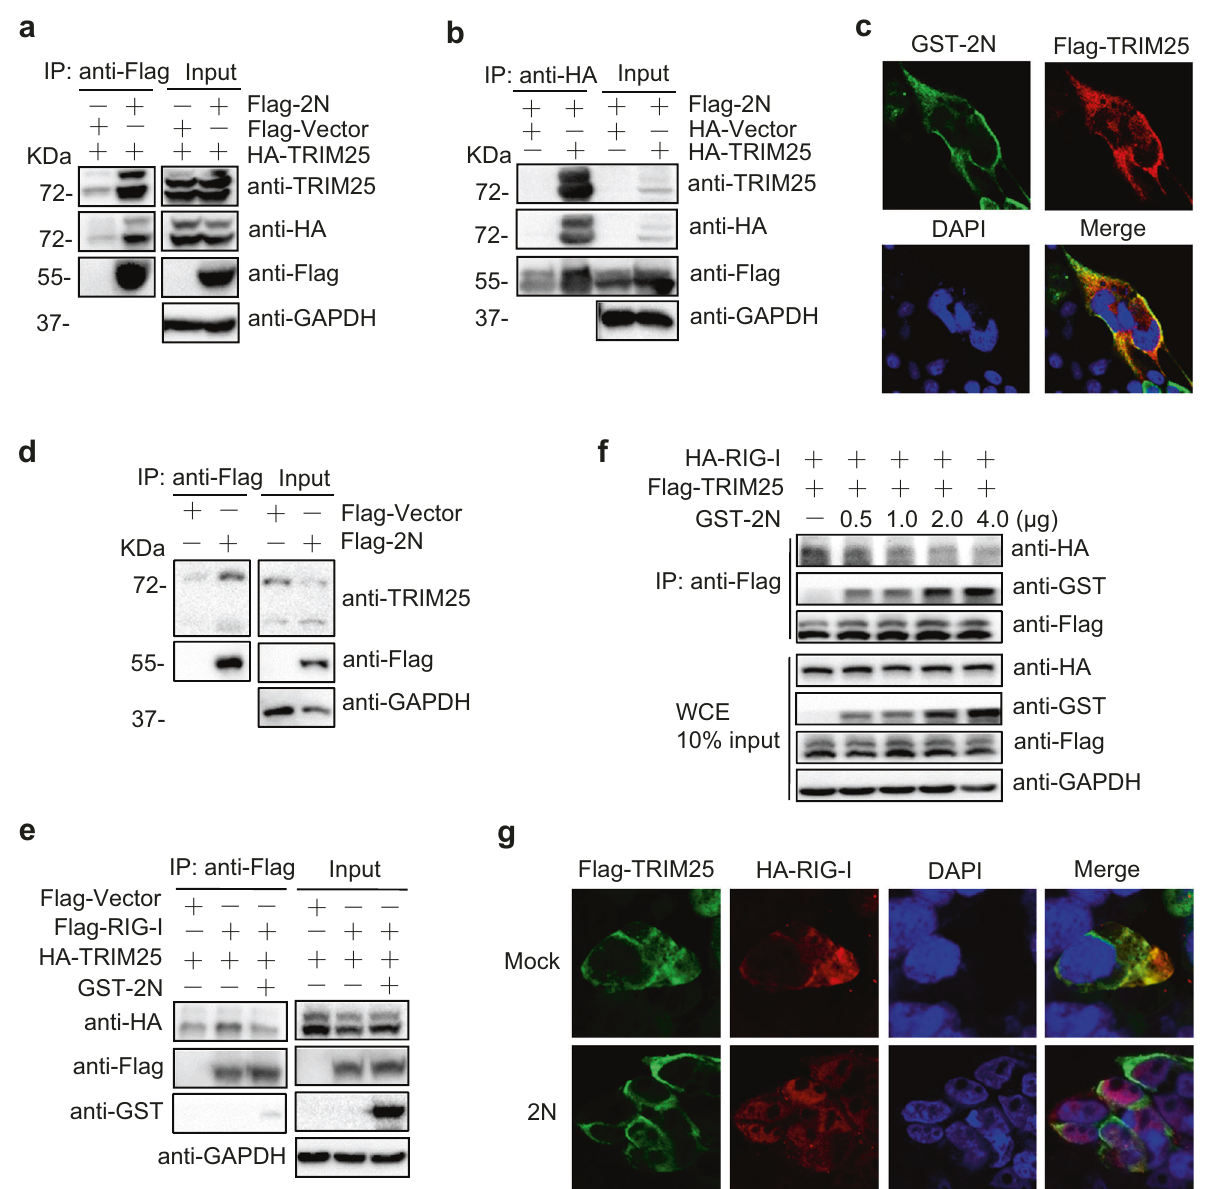
Fig. 5 2N protein inhibits the interaction of TRIM25 and RIG-I through competitively binding to TRIM25. a HEK293T cells were transfected with the plasmids expressing 1 μ g Flag-tagged SARS-CoV-2 N (Flag-2N) or empty-vector together with HA-TRIM25 in six-well plate. After 24 hpt, the cell lysates were subjected to anti-Flag immunoprecipitation (IP) and analyzed by immunoblot with anti-TRIM25, HA, and Flag antibodies, GAPDH was used as a loading control. b HEK293T cells were transfected with the indicated plasmids as in a for 24 h, the cell lysates were subjected to anti-HA IP and analyzed by immunoblot. c HEK293T cells were transfected with the plasmids expressing 0.25 μ g GST-2N and Flag-TRIM25 in 24-well plate. After 24 hpt, the cells were subjected to immuno fl uorescence with anti-GST and Flag antibodies. d HEK293T cells were transfected with Flag-2N or empty vector for 24 h, the cell lysates were subjected to anti-Flag IP and analyzed by immunoblot with anti-TRIM25 and Flag antibodies. e HEK293T cells were transfected with Flag-RIG-I or empty vector and HA-TRIM25, together with or without 1 μ g GST-2N plasmids in six-well plate. At 24 hpt, anti-Flag immunoprecipitates were analyzed by immunoblot. f HEK293T cells were transfected with Flag-TRIM25 and HA-RIG-I, together with an increasing concentration of GST-2N for 24 h in 6-well plate, anti-Flag immunoprecipitates were analyzed by immunoblot. g HEK293T cells were transfected with Flag-TRIM25 and HA-RIG-I, together with or without 0.25 μ g 2N plasmids in 24-well plate. After 24 hpt, the transfected cells were subjected to immuno fl